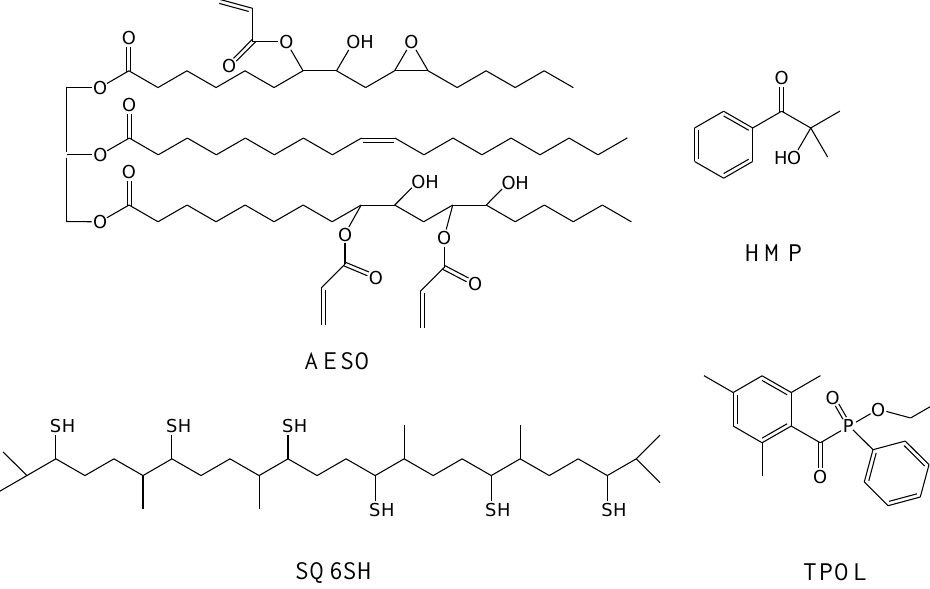
Figure 1. Chemical structures of acrylated epoxidized soybean oil (AESO), hexathiolated squalene (SQ6SH), 2-hydroxy-2-methylpropiophenone (HMP), and ethylphenyl (2,4,6-trimethylbenzoyl) phosphinate (TPOL).